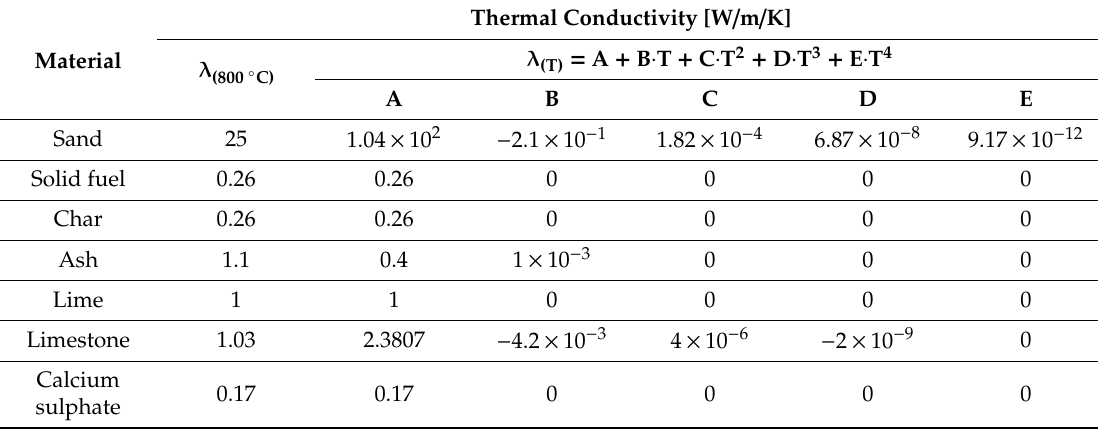
Table 6. Thermal conductivity of solid particles in the